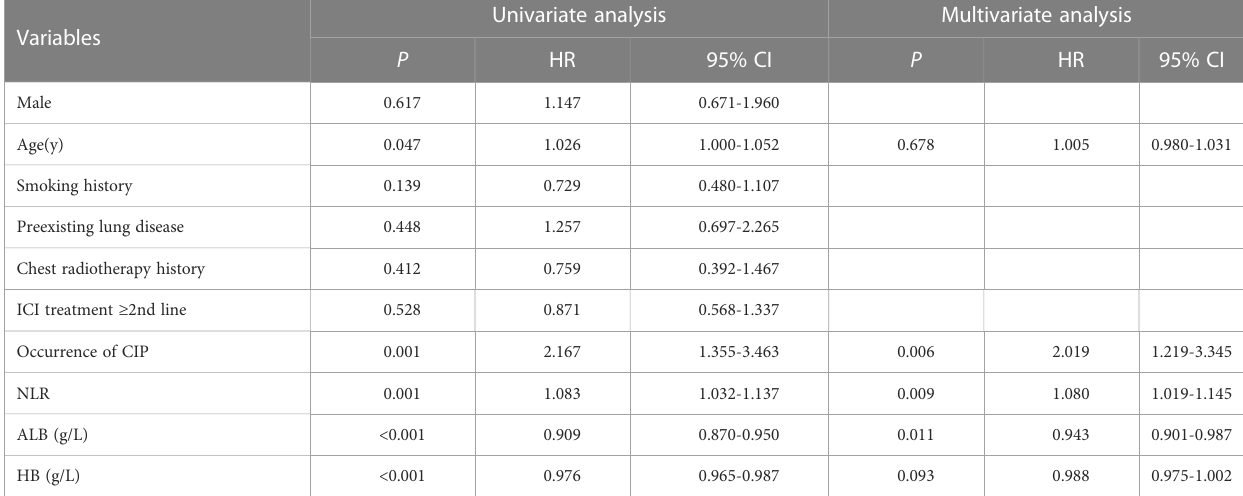
TABLE 4 Analyses of factors potentially associated with overall survival of the advanced NSCLC patients treated with ICIs.